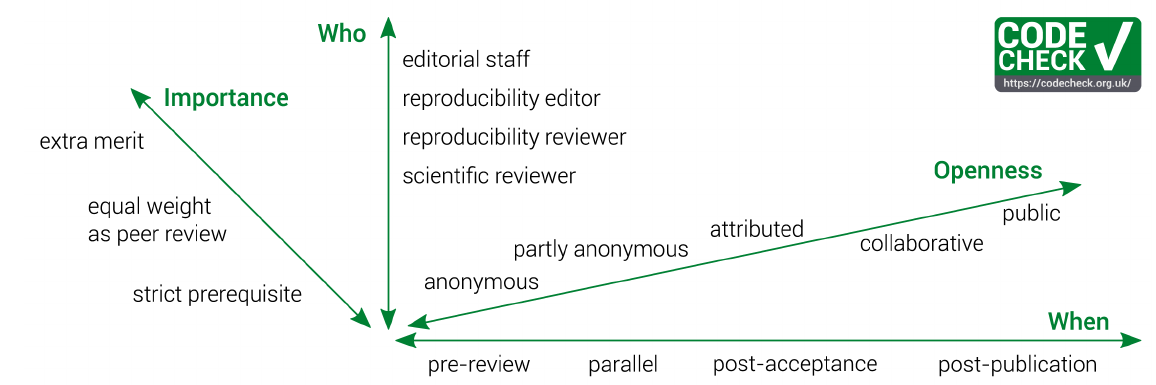
Figure 3. The dimensions of implementing a CODECHECK